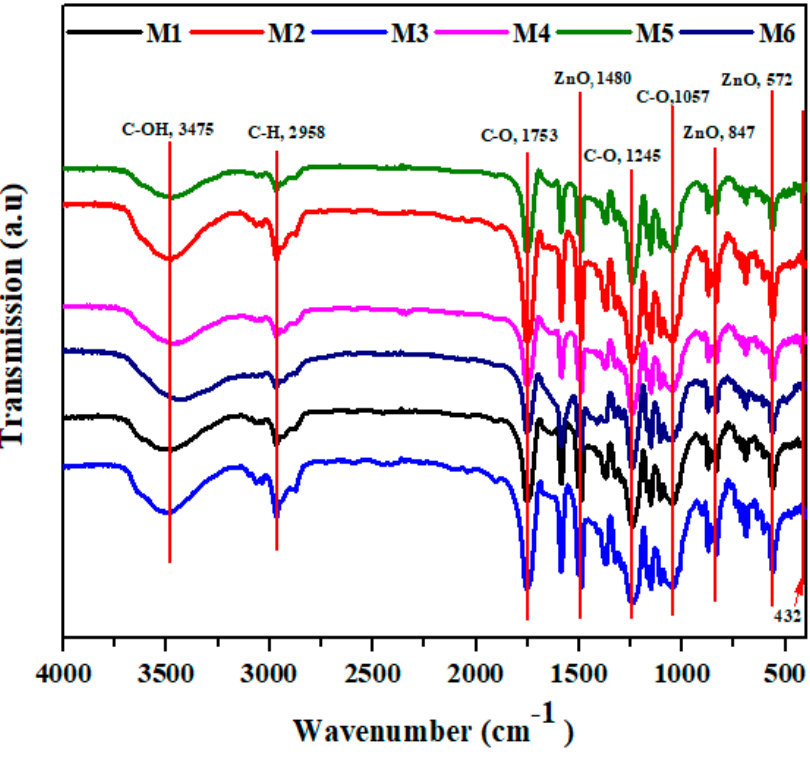
Figure 7. The figure shows the main Fourier transform infrared (FTIR) peak analysis of the developed